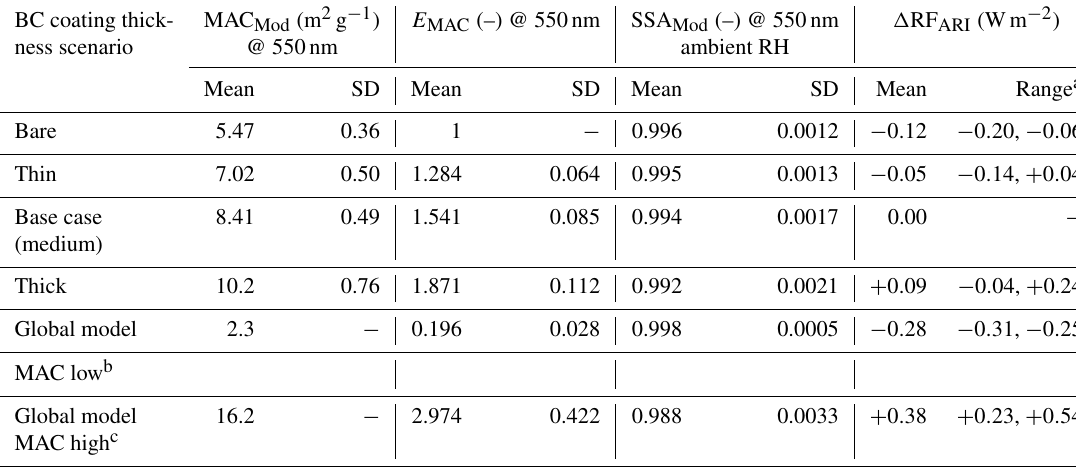
Table 3. Campaign average and standard deviation of optical properties of black carbon and total aerosol for different BC coating thickness scenarios and resulting radiative implications. The base case BC coating thickness scenario (“medium”) reflects the median of all measured values, while the “thin” and “thick” scenarios reflect the 25th and 75th percentiles, respectively. The scenarios “global model MAC low” and “global model MAC high” reflect extreme values applied in previous global model simulations. The black carbon mass absorption cross section (MAC Mod ) is estimated with Mie theory; MAC enhancement ( E MAC ) is defined as the relative increase in BC MAC due to the lensing effect compared to bare BC. The single-scattering albedo (SSA Mod ) used in the radiative transfer simulations is inferred from measured aerosol optical properties. The change in radiative forcing from aerosol radiation interactions ( (cid:49) RF ARI ) is defined as the simulated RF ARI minus that of the base case